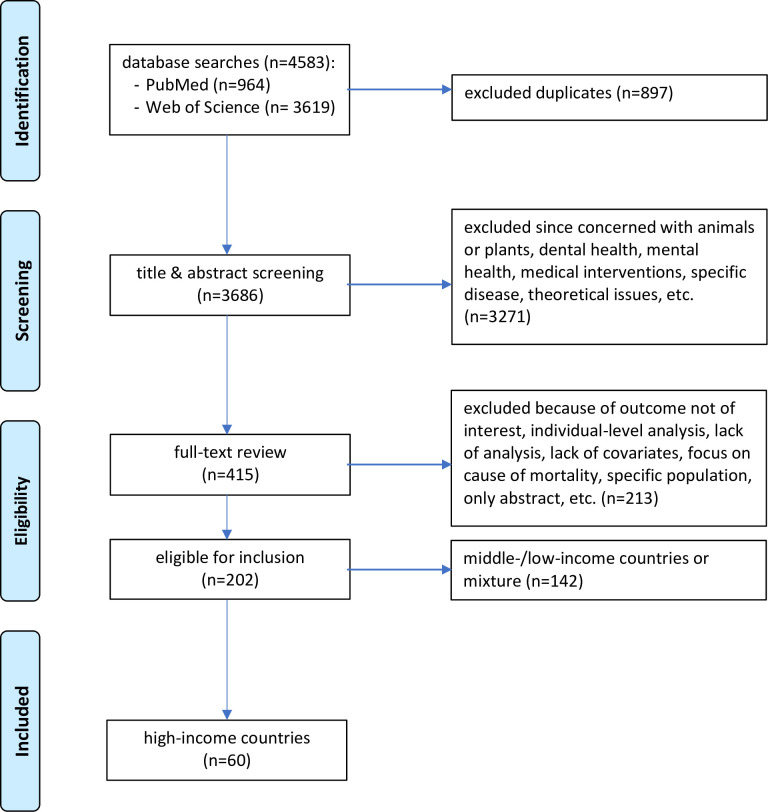
PRISMA flow-diagram.